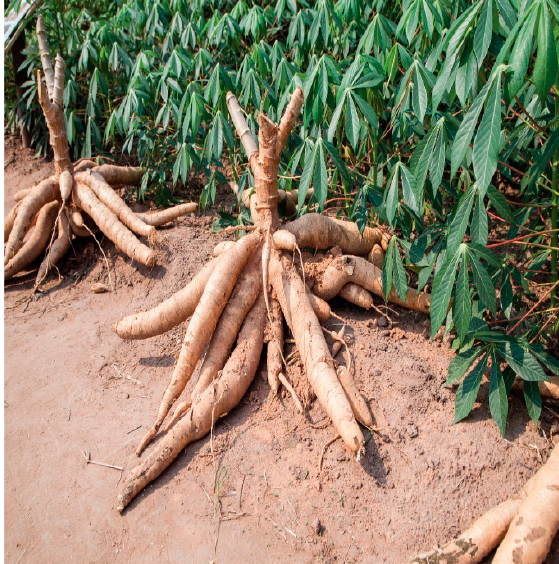
Figure 2. Typical Cassava crop Figure 2 . Typical Cassava crop harvest. Figure 2 . Typical Cassava crop harvest.